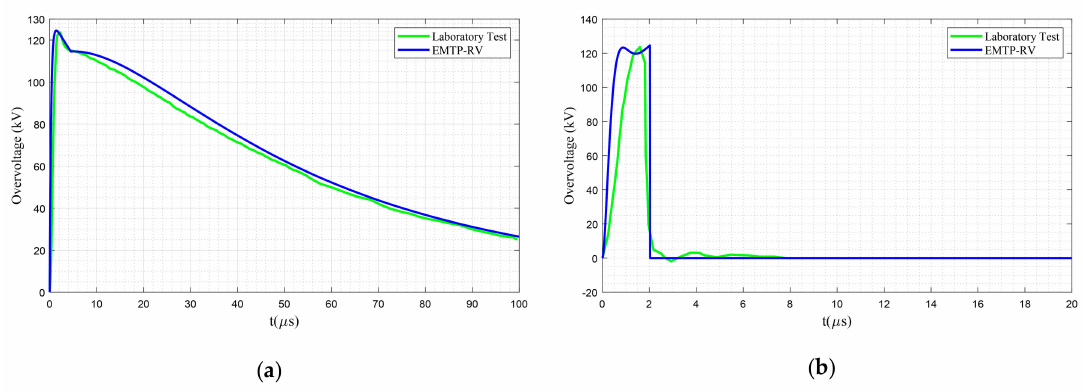
Figure 10. ( a ) Applied nonstandard 125 kV lightning impulse. ( b ) Measured overvoltage stress at the presence of spark gap